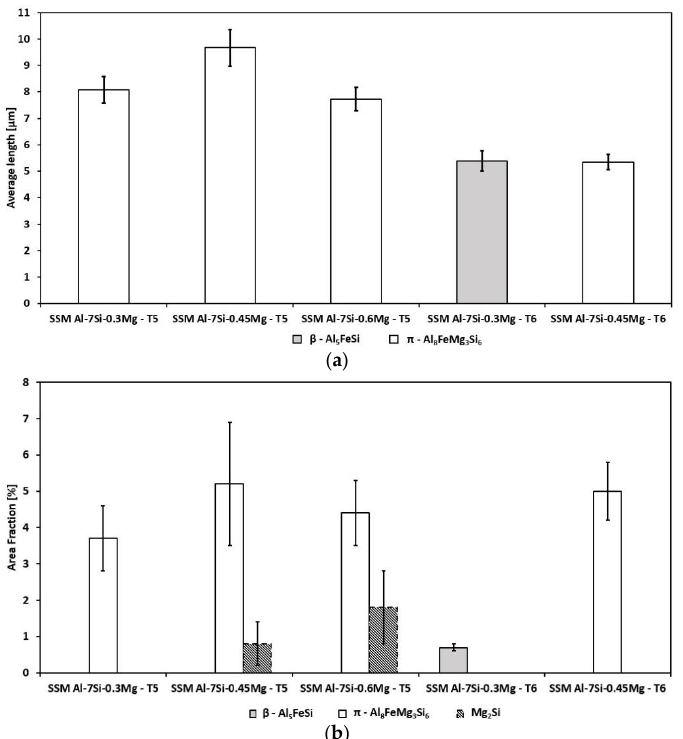
Figure 4. ( a ) Average length of β -Al 5 FeSi and π -Al 8 FeMg 3 Si 6 phases. ( b ) Area fraction of the inter- metallic phases detected in the SSM castings. Error bars show the standard error of the measure-